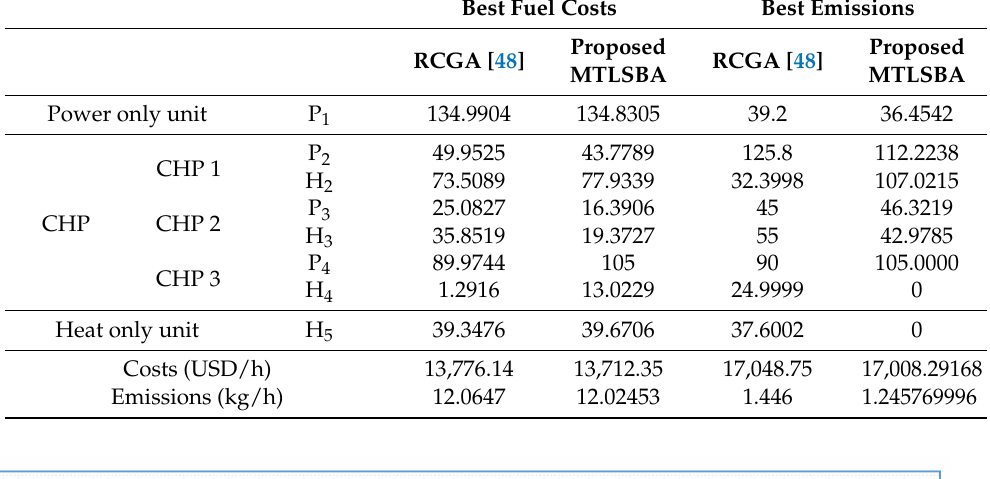
Table 2. Results of best fuel costs and emissions of test system 1 using the proposed MTLSBA.